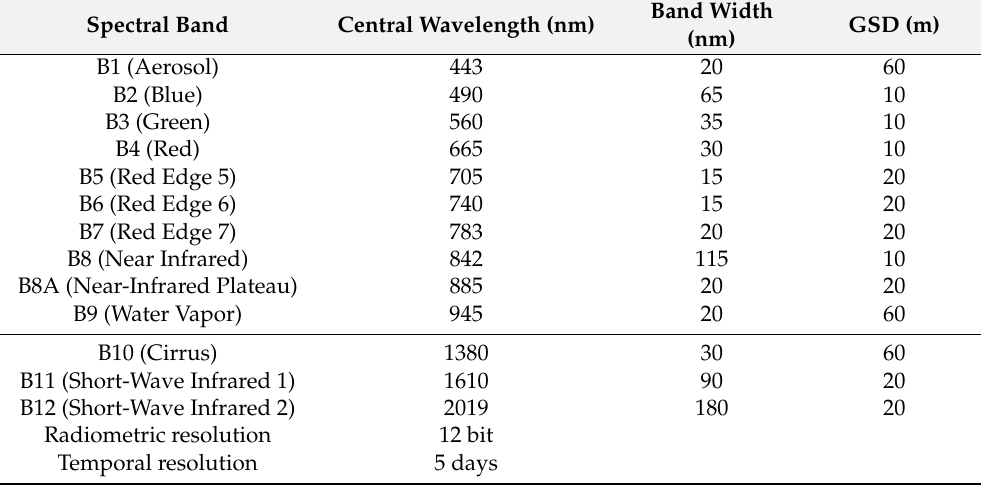
Table 2. S2 band technical features: central wavelength, bandwidth, ground sample distance (GSD), radiometric resolution and temporal resolution